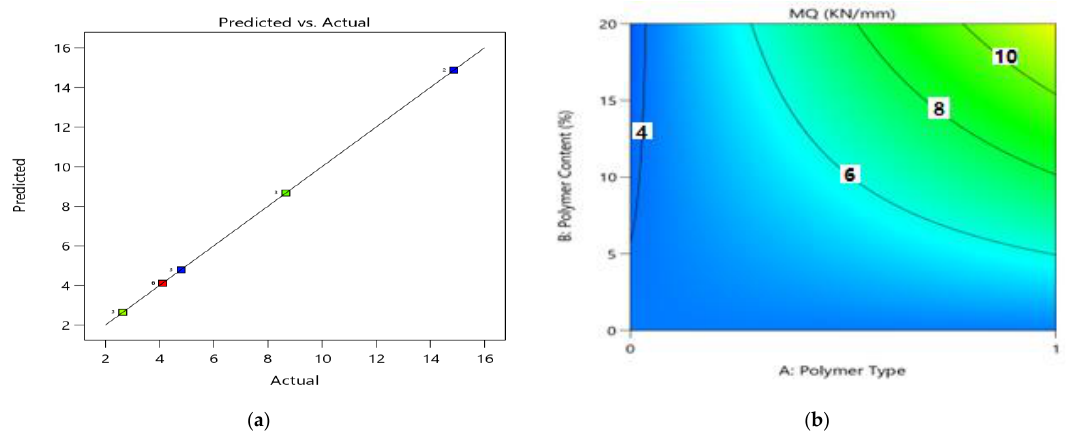
Figure 14. ( a ) Predicted vs. actual plot for MQ (kN/mm) ( b ) contour plot (2D) between the MQ (kN/mm) and three factors.